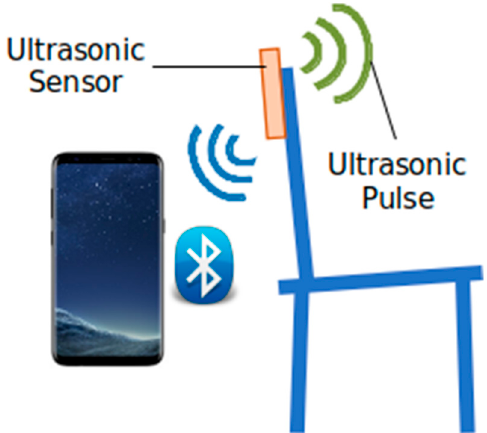
Figure 2. Depiction of the experimental set-up. The chair–stand sensor was attached to the backrest of a regular rigid chair. The chair–stand sensor emitted ultrasonic pulses toward the subject’s back. An Android app in a mobile device was used to control the chair–stand sensor via Bluetooth and to store the sensor readings for subsequent analysis.